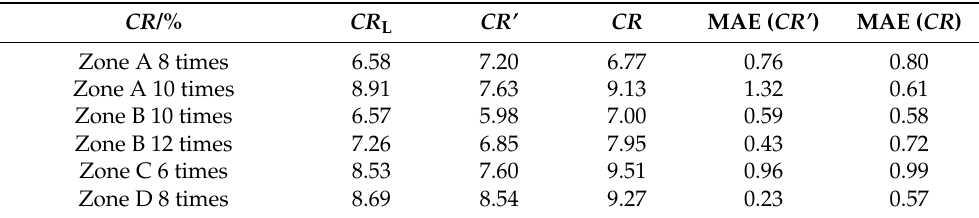
Table 5. Error of ECPs in subregional